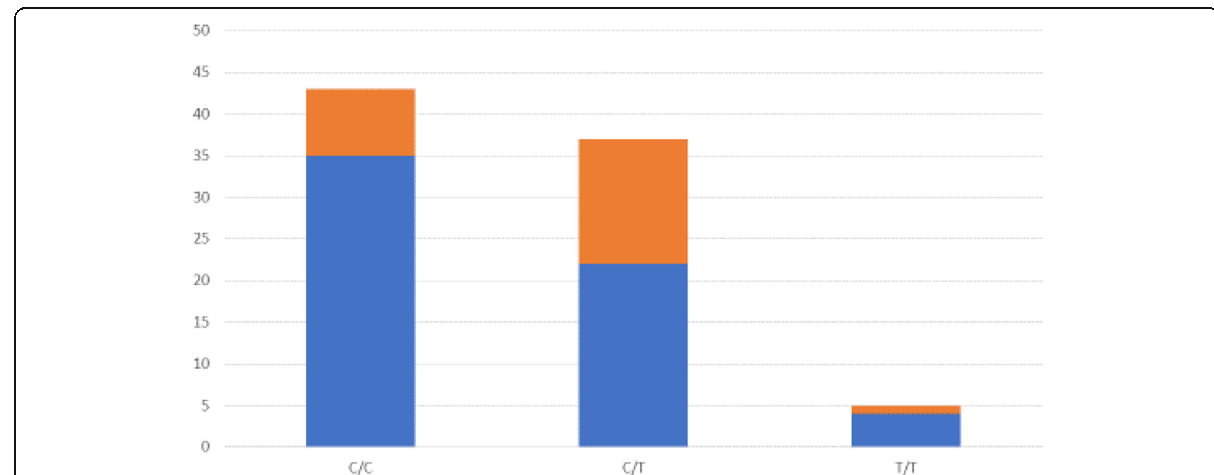
Fig. 2 Genotypic distribution of the c.957C>T (rs6277) SNP, regarding attention problems and hyperactivity. Above: substantial; Below: